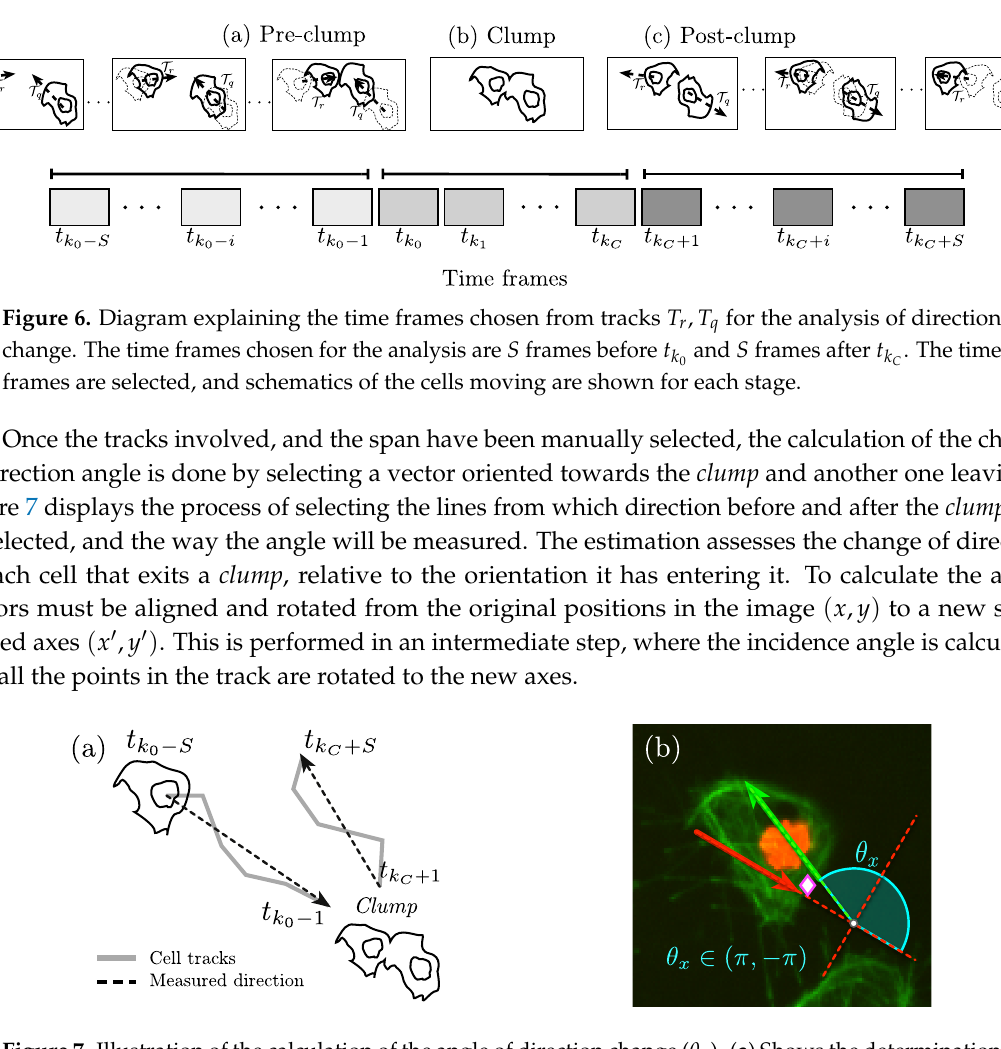
and 0 − S and t k . C + 1 C + S